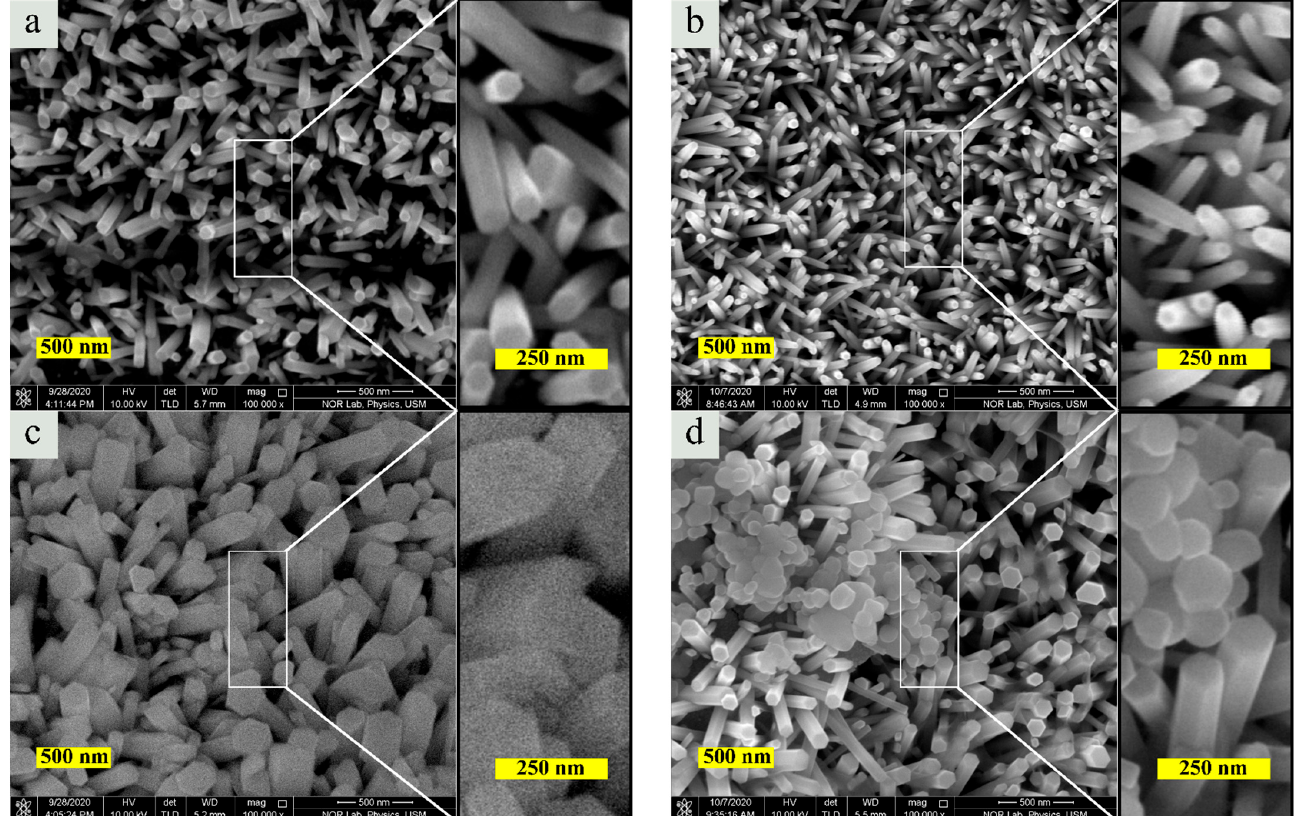
Figure 2. FESEM images show the morphology of the grown samples at different concentrations of TiO 2 /ZnO on PTFE substrates: ( a ) S 1 , ( b ) S 2 , ( c ) S 3 , and ( d ) S 4 . Table 1. EDX atomic percentages for the synthesis of nanocomposites on PTFE substrates (S 1 )